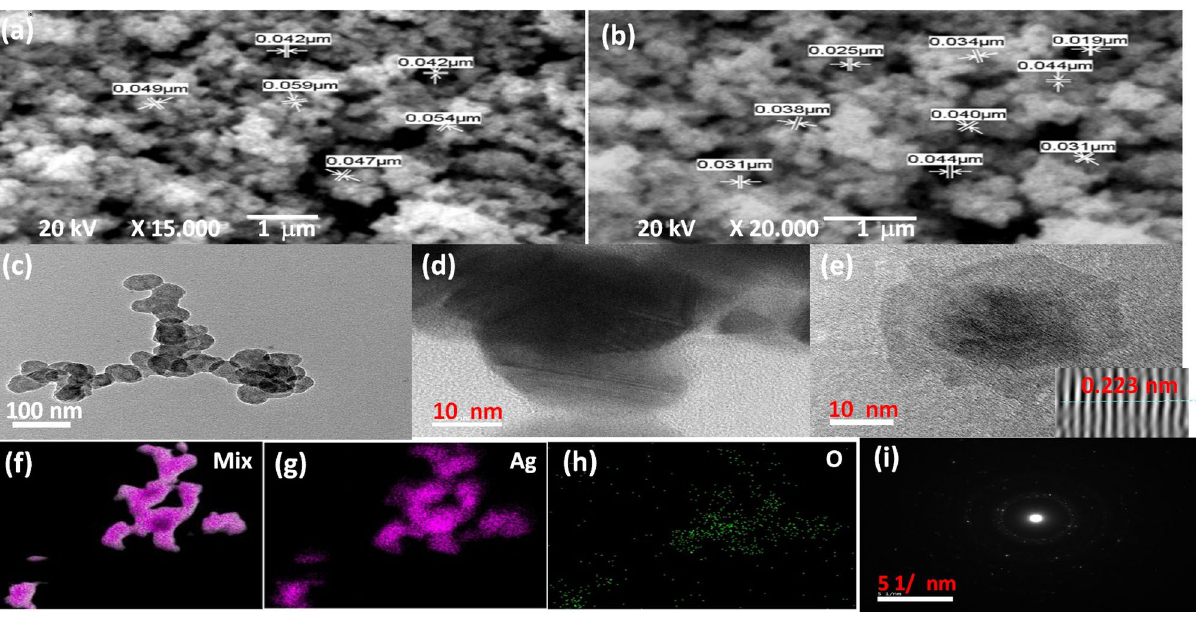
Figure 4. ( a , b ) SEM images at different magnifications, ( c ) TEM, ( d , e ) HRTEM, ( f – h ) elemental mapping distribution and ( i ) SAED pattern of the Ag@Ag 2 O